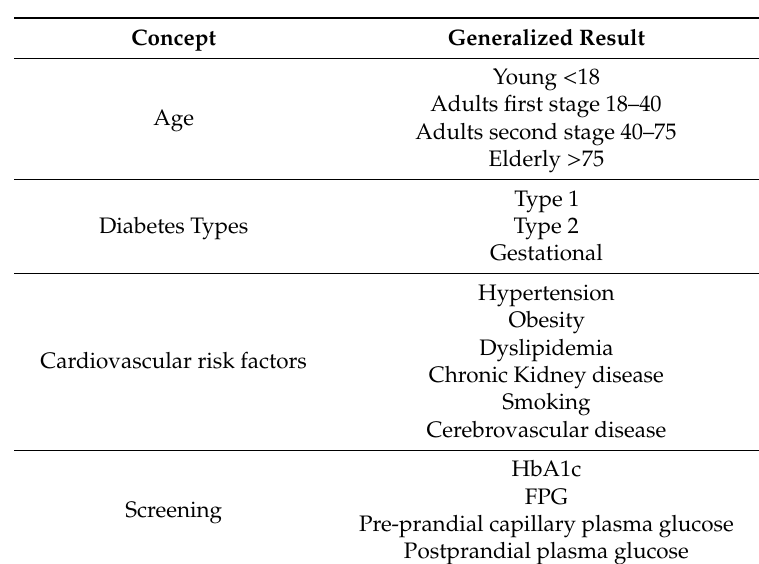
Table 1. Generalization of key